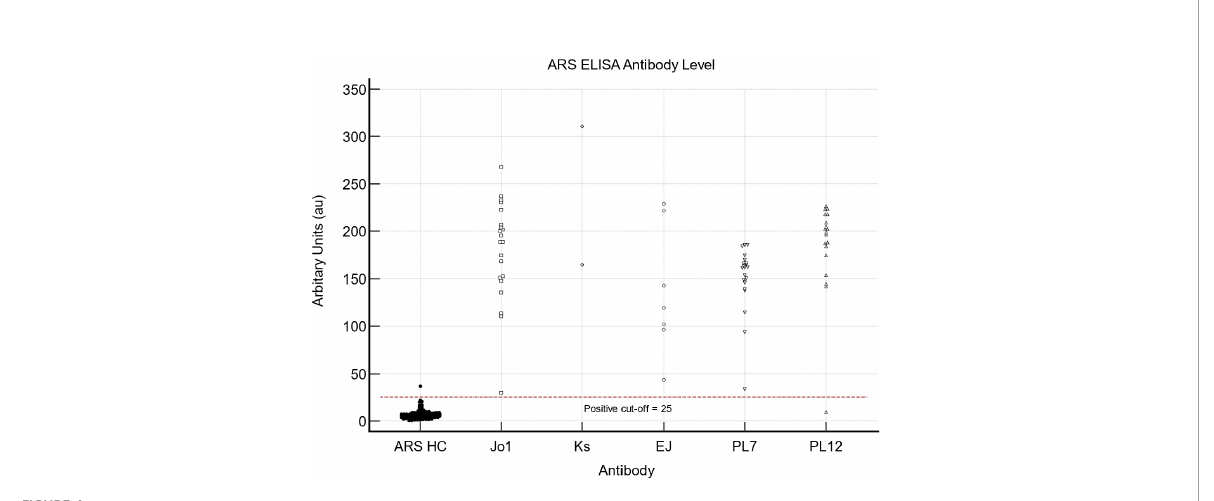
FIGURE 4 Individual ELISA values for individual ARS antibodies and HC